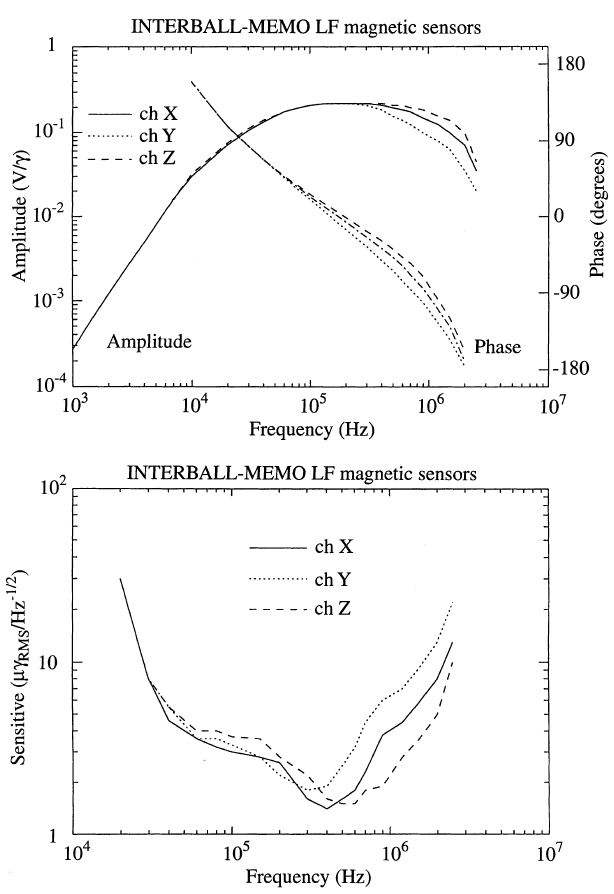
Fig. 3. Transfer functions and sensitivity curves of the LF